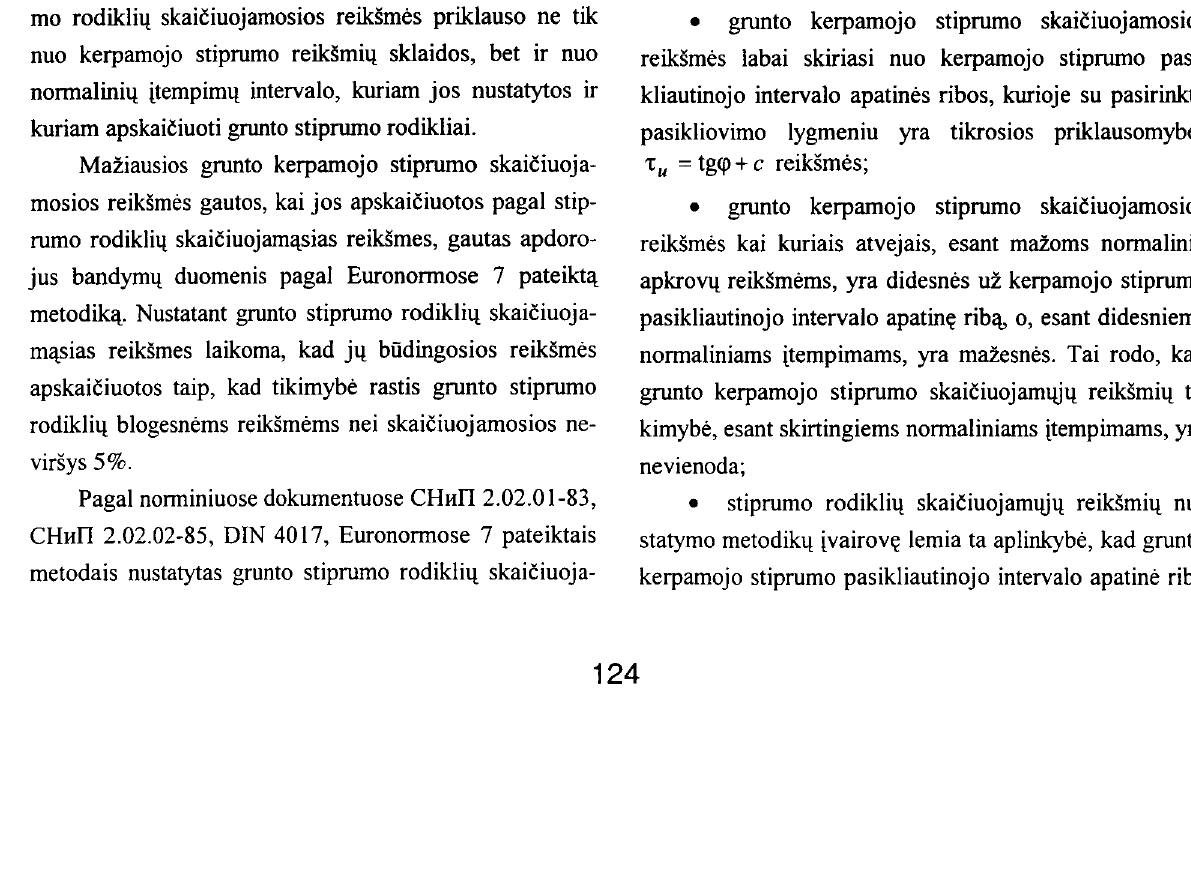
Fig 5. Shear strength values: 1 - average, 2, 3 - control limits, 4- test results, 5, 6, 7, 8- determined according to CHHTI 2.02.01-83, CHHTI 2.02.02-85, DIN 4017, Euro code 7 Apibendrinus kirpimo bandyml! duomen4